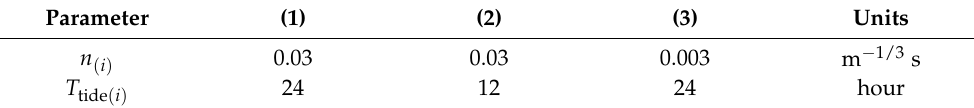
Table 4. Parameters varied for three test cases of modeling inundation of an intertidal zone. Parameter